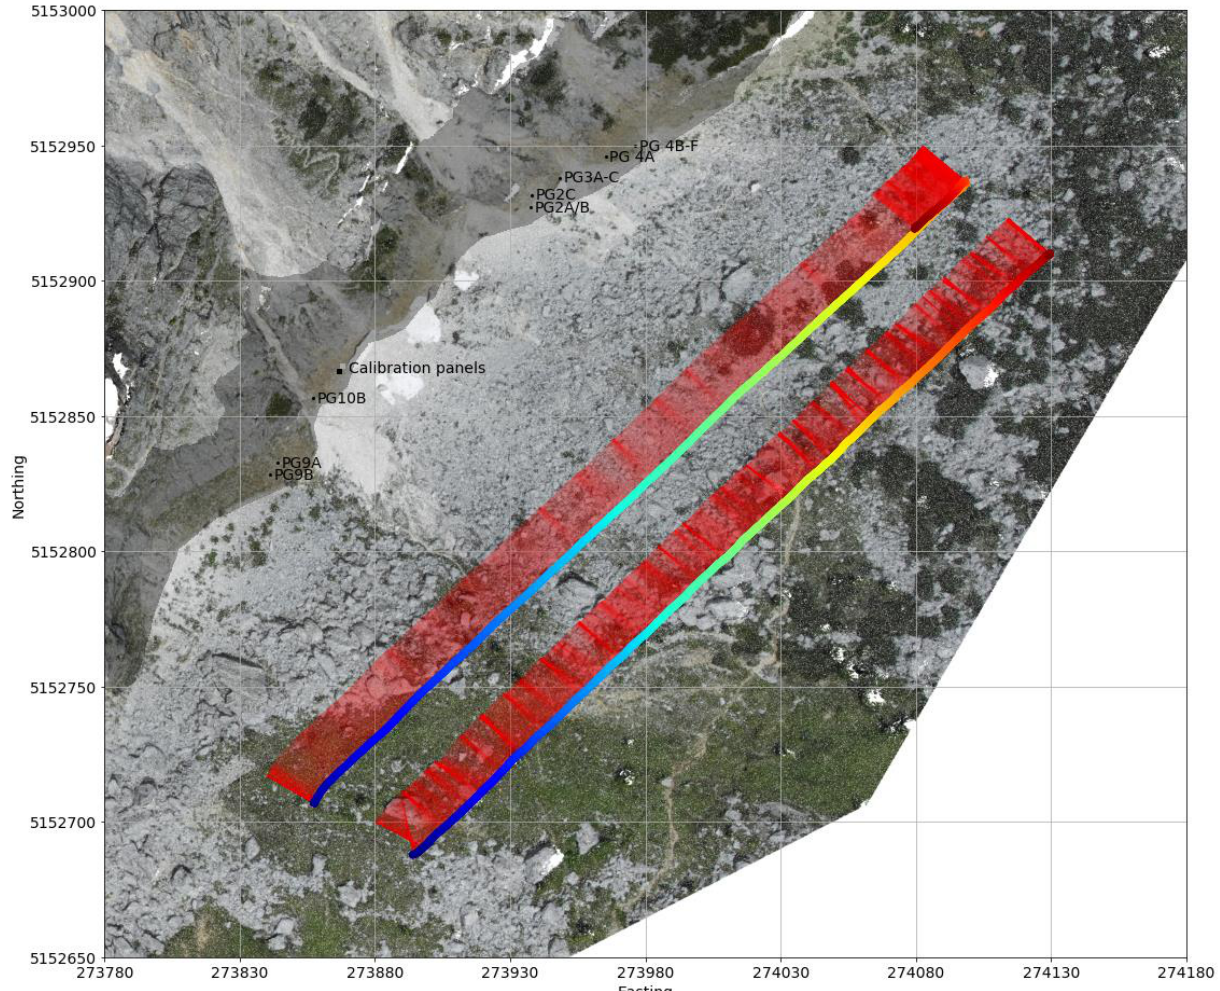
Figure 5. Post processed flight paths for flight A and B draped over the photogrammetric model. Coloured points show the camera position at each frame (line of hyperspectral data), with blue at the start of each survey and red at the end. The closely spaced red vectors show the camera viewing direction at each of these positions. The transparent grey area shows the map-view extent of the surveyed section of cliff. The location of the Zenith calibration panels (Section 3.5) and ground-truth spectra (Section 3.7) are also overlain for reference.